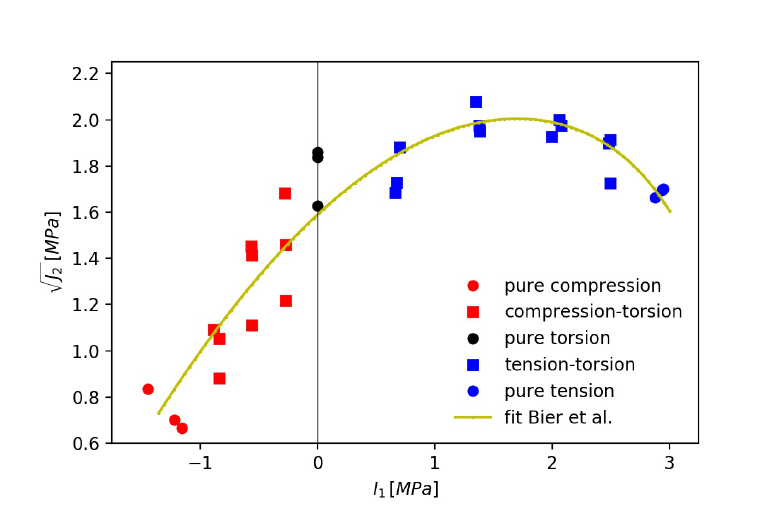
Figure 3. Failure data in the invariants plane and fitting of the failure criterion proposed by Bier et al.